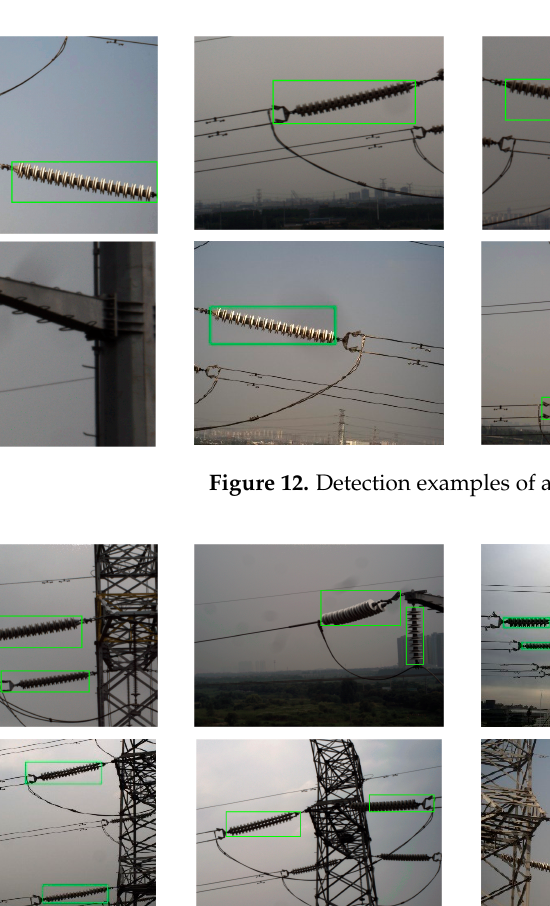
Figure 11. Detection examples of insulators in complex backgrounds.